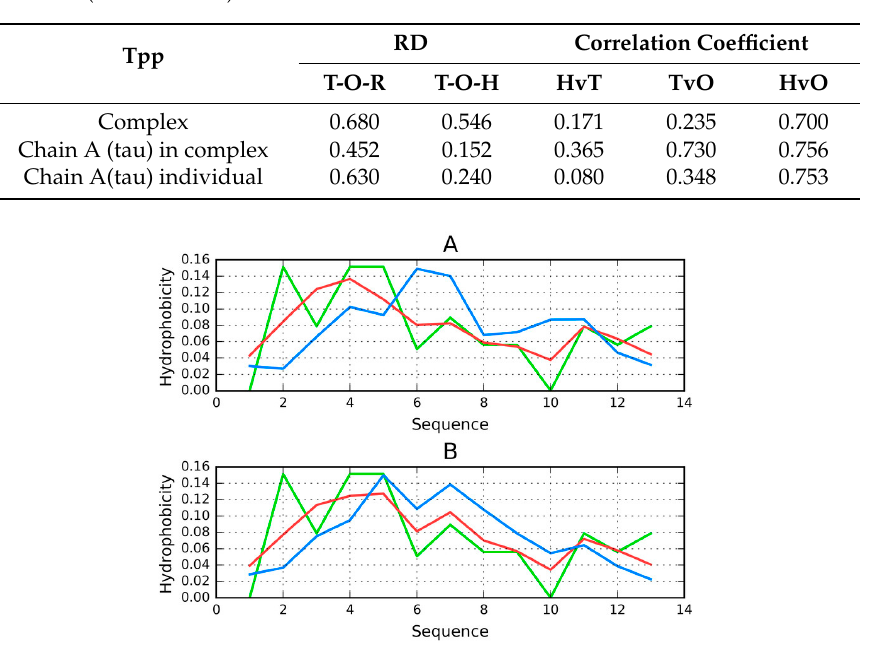
Table 6. Parameters describing the 541–553 fragment (chain A) of the tau protein Tpp in complex with the ww domain (residues 6–44).